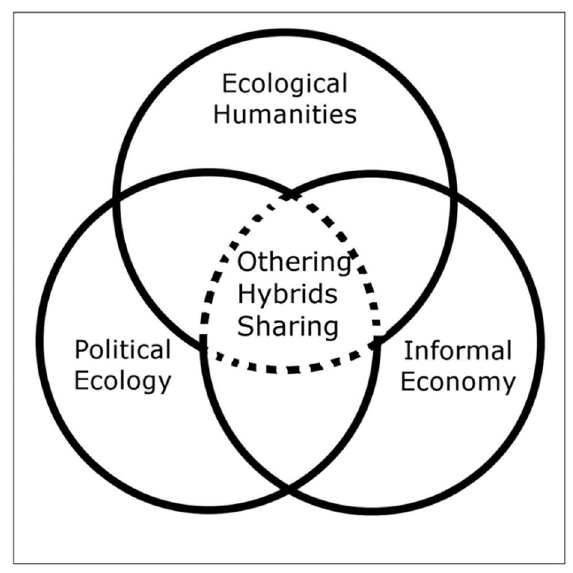
Figure 1. Overlapping Themes of Political Ecology, the Ecological Humanities, and the Informal Economy